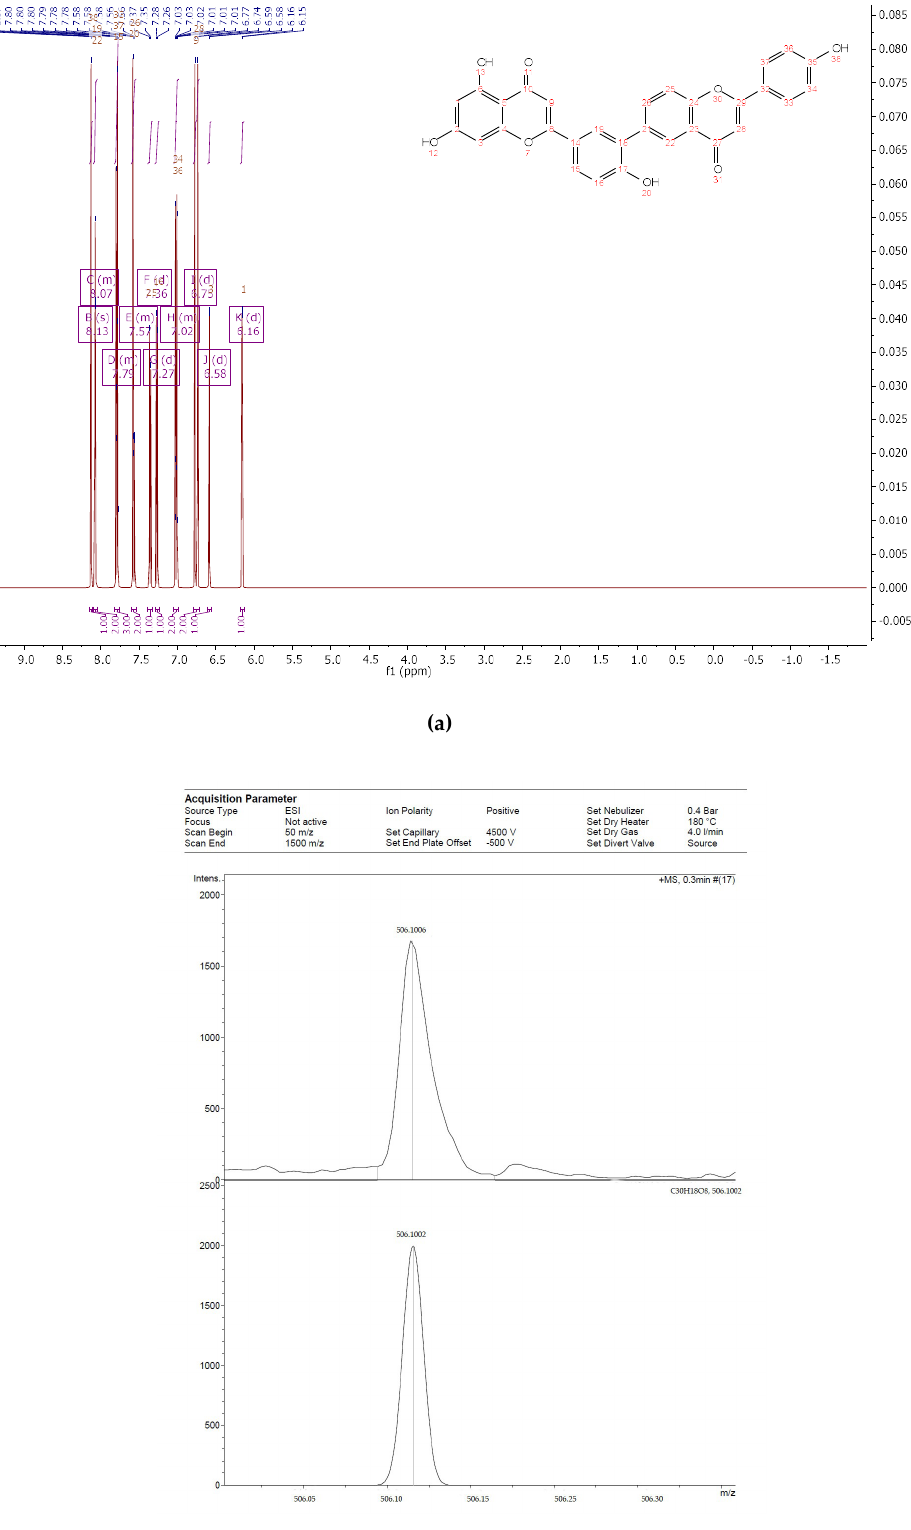
Figure 5. 1 H NMR ( a ) and HRMS ( b ) spectrum of 5,7-dihydroxy-2-(4-hydroxy-3-(2-(4-hydroxyphenyl)-4-oxo-4H-chromen- 6-yl)phenyl)-4H-chromen-4-one from extracts of callus, cell suspension, and root cultures of Rhodiola rosea